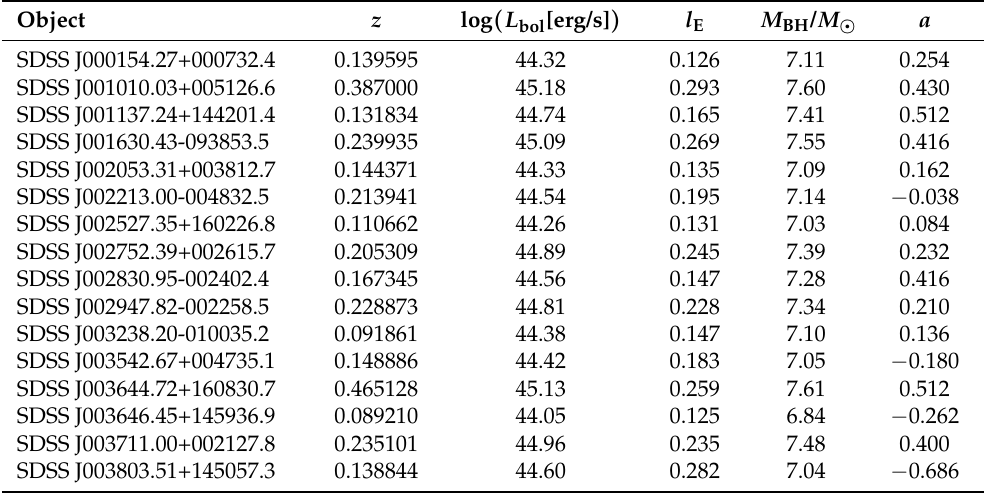
Table A1. All objects with their estimated spin values. Part 1 of 8. Columns indicate: (1) object name, (2) cosmological redshift, (3) bolometric luminosity, (4) mass of SMBH, and (5) estimated spin